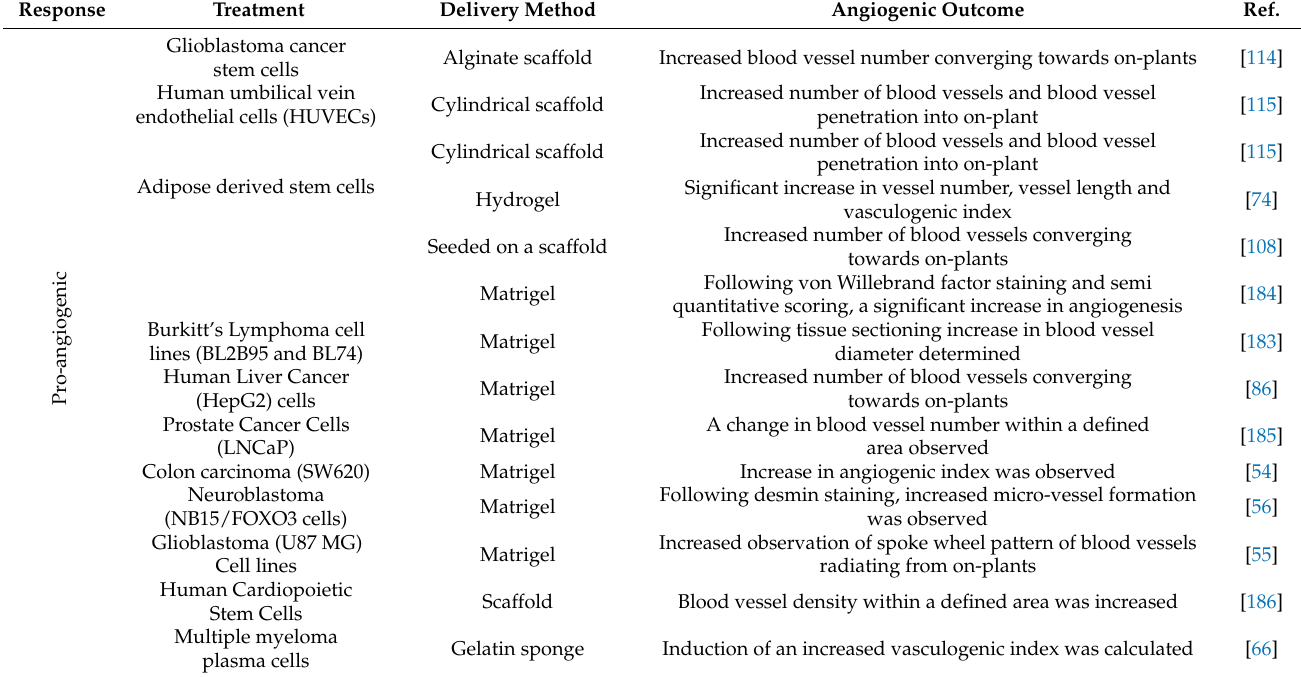
Table 4. Examples of cellular treatments/ tumours applied to CAM which affected